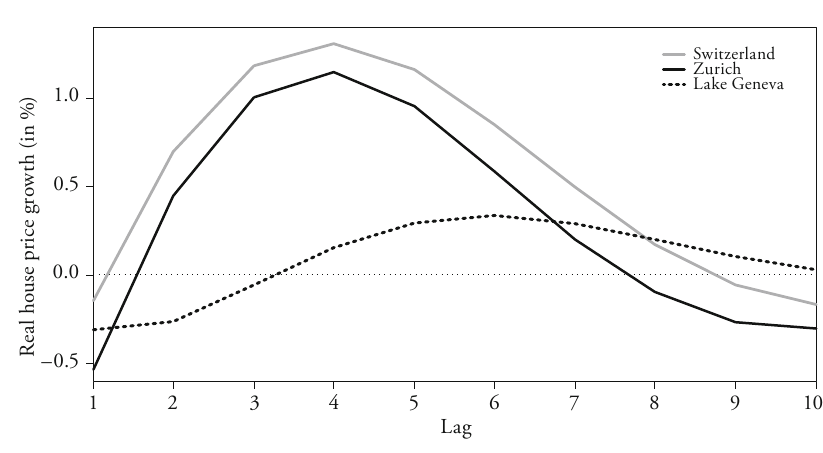
Figure 15: Regional Analysis: Response of House Prices to a Shock on the Unemployment